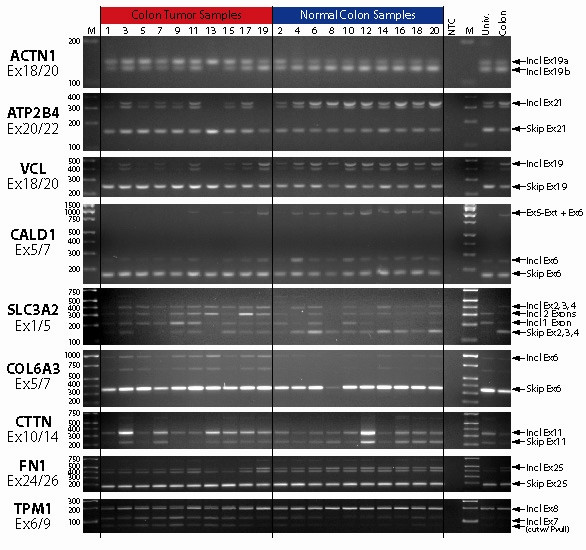
PCR validation of candidate splicing events. PCR products are derived from forward/reverse primers in well-annotated flanking regions as indicated under the gene name. The interpretation of each change in mobility is given to the right ("Incl", include; "Ext", extended). The sample numbers match those in the sample data information (see Methods). Note that in several cases, an unlabeled doublet band results from a heteroduplex forming between the PCR products. Controls are "Universal Total RNA" (Clontech), an independent colon RNA sample (BioChain) and a No Template Control ("NTC"). "M" is a DNA ladder marker.